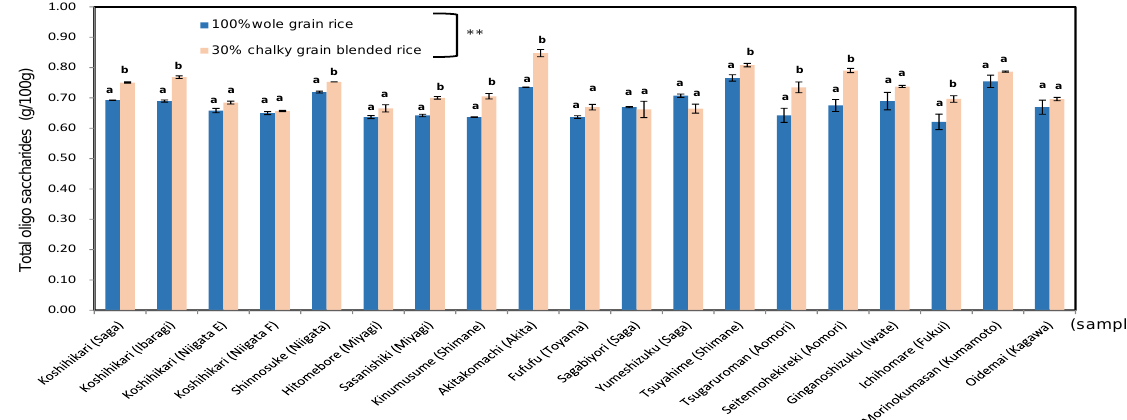
Figure 6. Total oligo saccharides of 100% whole rice boiled grains and 30% chalky rice blended grains in 19 kinds of Japonica rice in 2020. Different letters (a, b) mean that whole and 30% chalky grains in each same rice samples are significantly different. ** Correlation is significant at 1% by the method of Tukey’s multiple comparison.